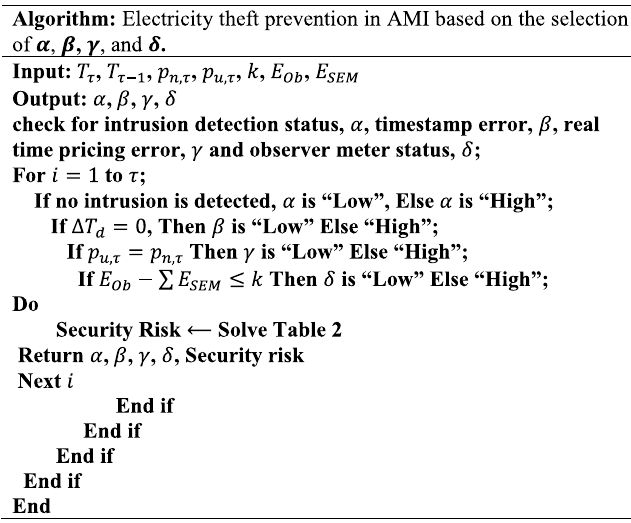
Table 3 Developed pseudocode for implementing the scenario